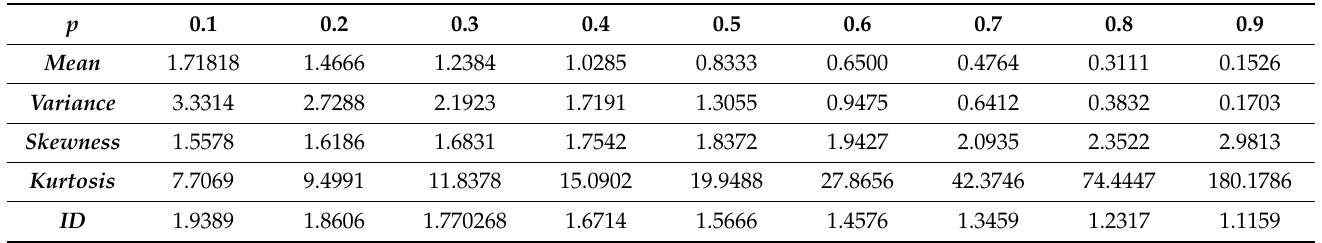
Table 1. Mean, Variance, Skewness, kurtosis and ID of the BNDL distribution for different values of the parameter p